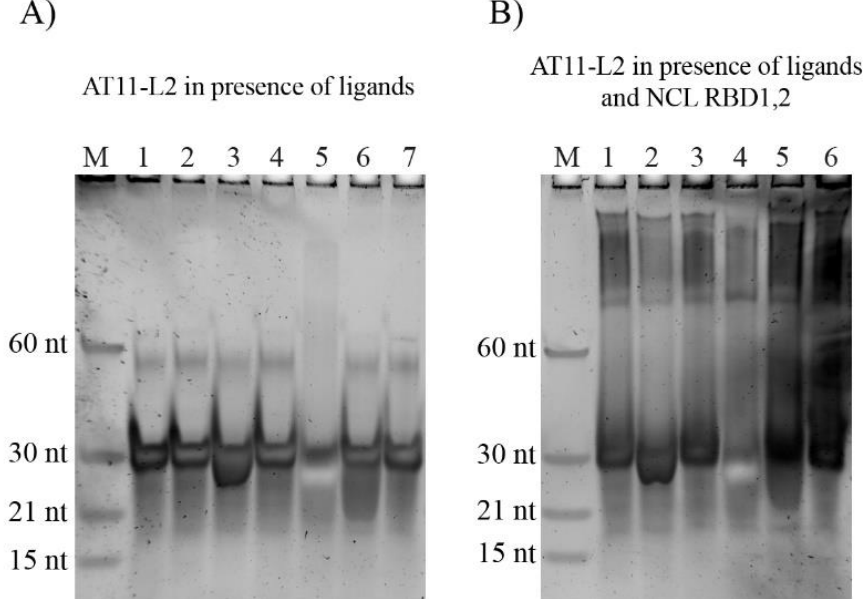
Figure 9. Non-denaturing gel electrophoresis of AT11- L2 G4 (2 μM) in ( A ) presence of ligands (4 μM) (Lanes: M— Marker; 1 — ultrapure water; 2 — annealing buffer; 3 — 360A; 4 — PhenDC3; 5 — TMPyP4; 6 — BRACO-19 and 7 — PDS) and ( B ) Ligands (4 μM) and NCL (2 μM) (Lanes: M— Marker;